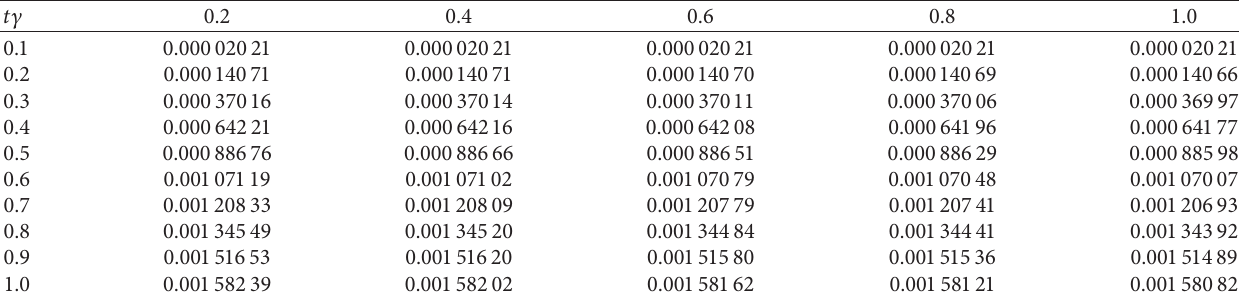
Table 6: Some values of w ( t, x ) for different values of c for P � 1 (for a butyl B252